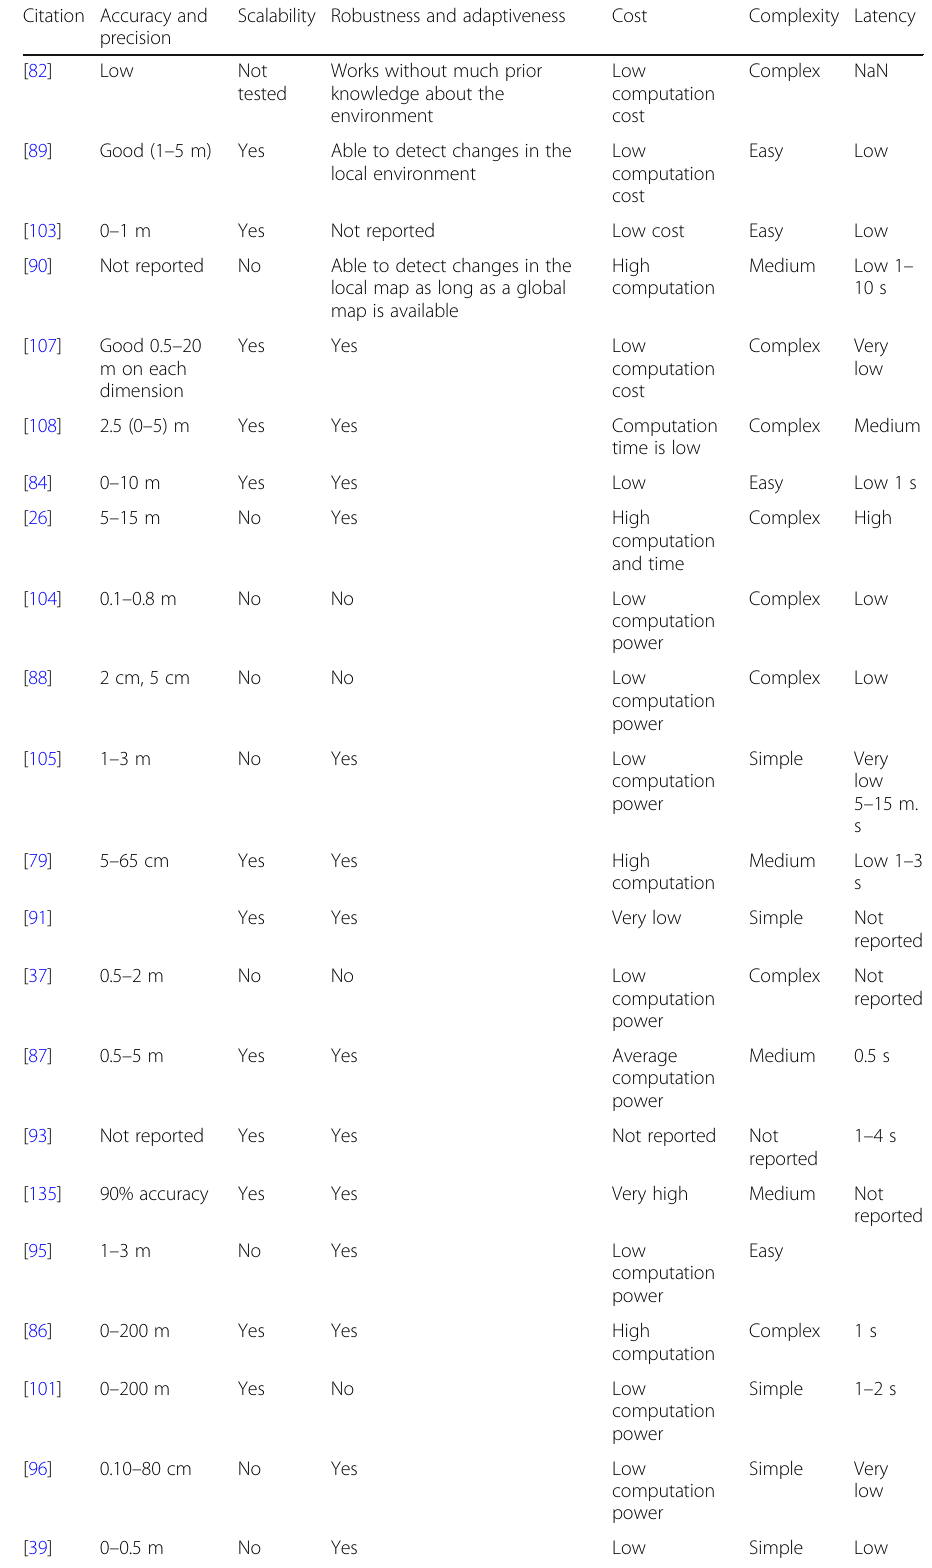
Table 2 System metrics Citation Accuracy and